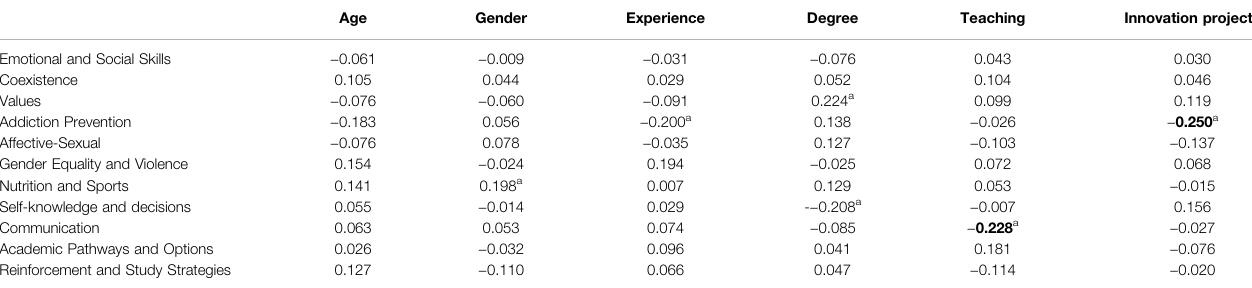
TABLE 1 | Spearman ρ (rho) Correlations between Counselor Pro fi le and the Transversal Content Addressed by Tutors. Age Gender Experience